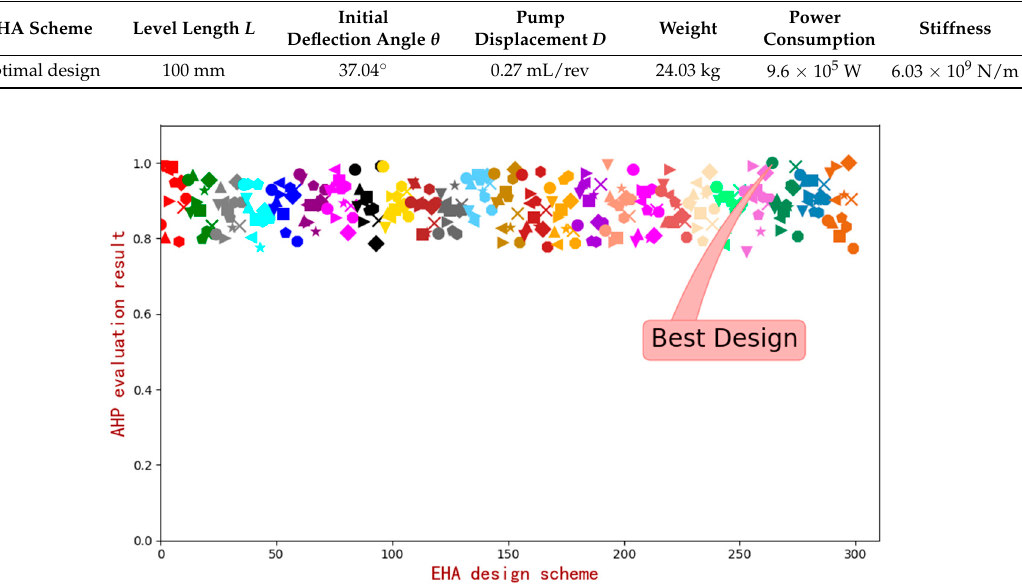
Figure 8. The AHP evaluation result of the Pareto frontier.